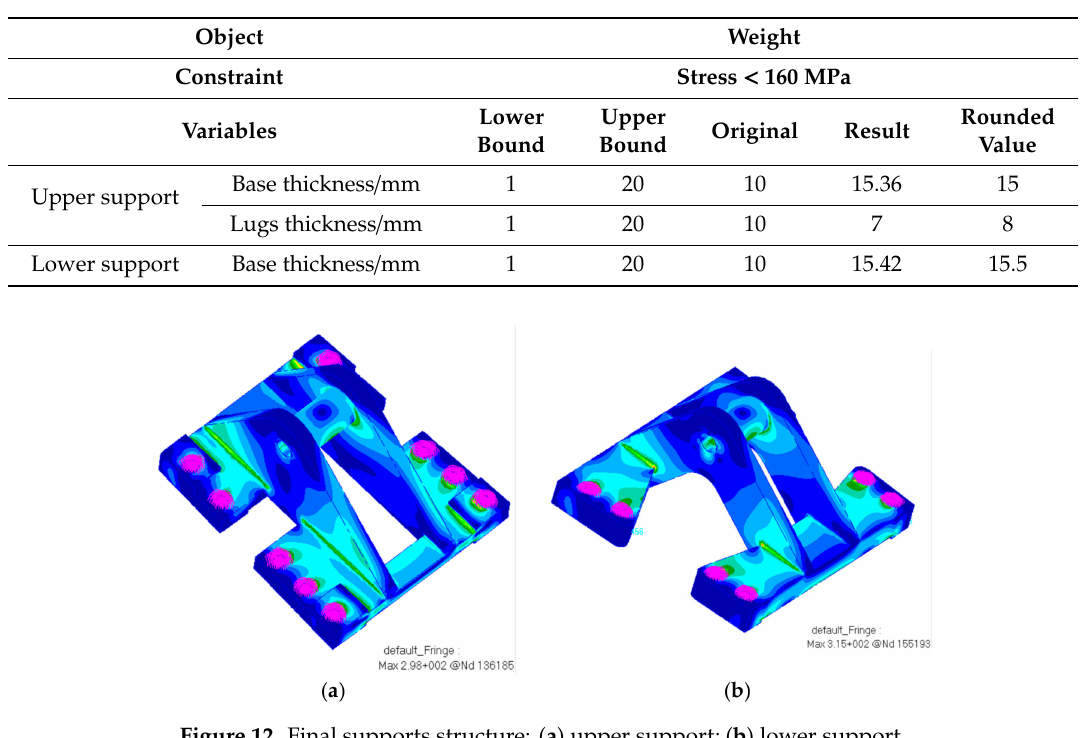
Table 5. Sizing optimization model and results.